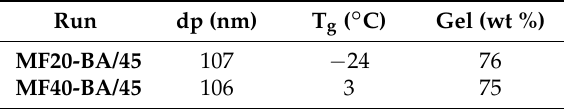
Table 3. Final copolymer characteristics.